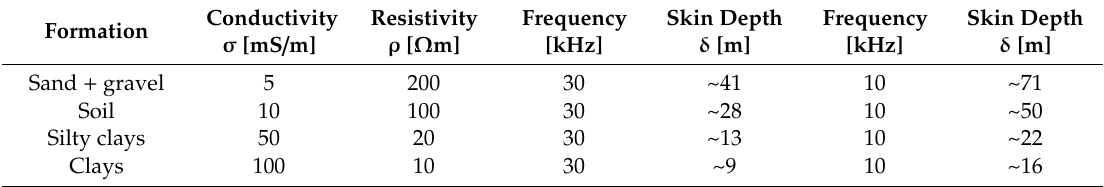
Table 2. Calculated skin depths in homogeneous half-space for several electromagnetic